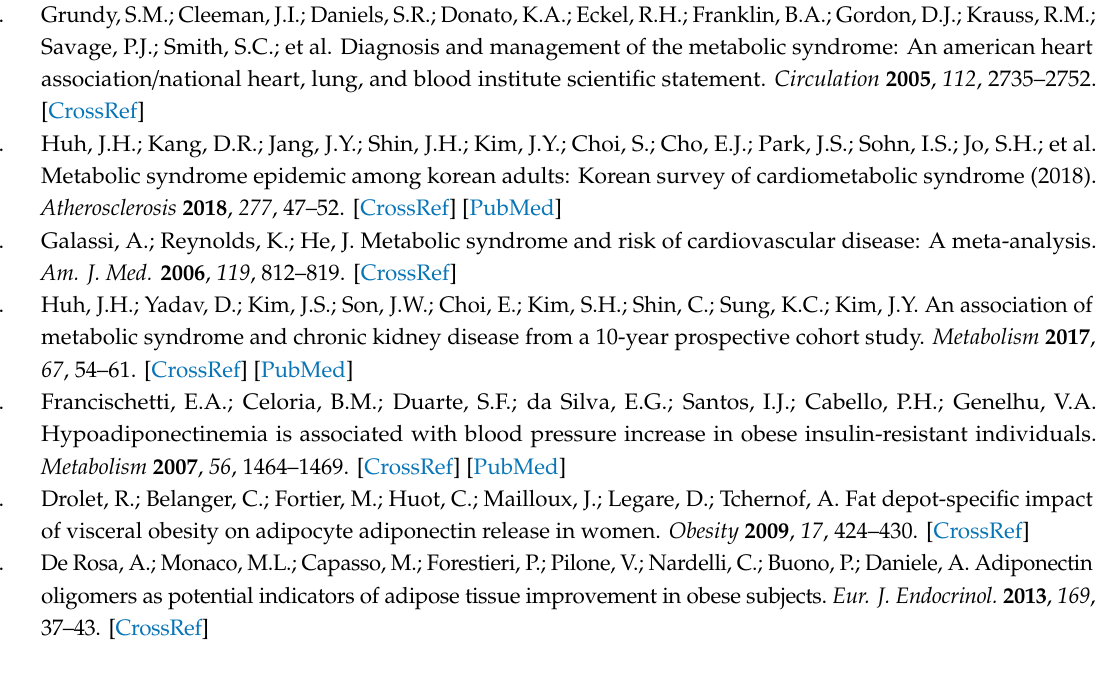
Table S1. Baseline characteristics of participants according to median of plasma adiponectin at baseline and change of plasma adiponectin during follow up period according to sex (A) Men, (B) Woman. Table S2. Adiponectin to leptin ratio levels according to development of metabolic